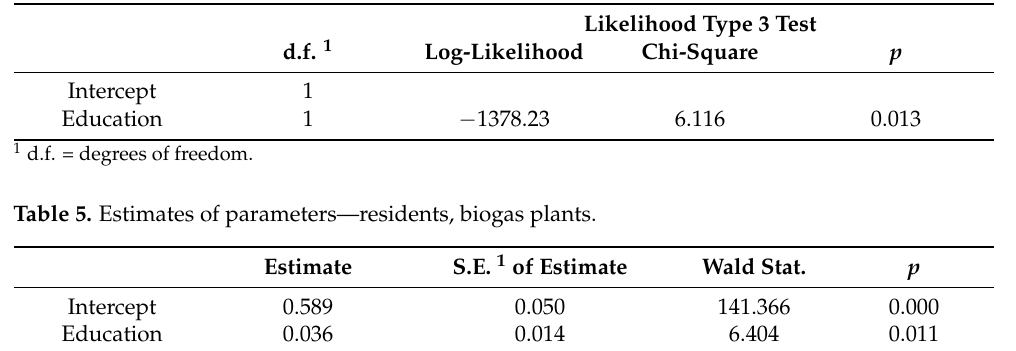
Table 4. Results of the regression model—residents, biogas plants.